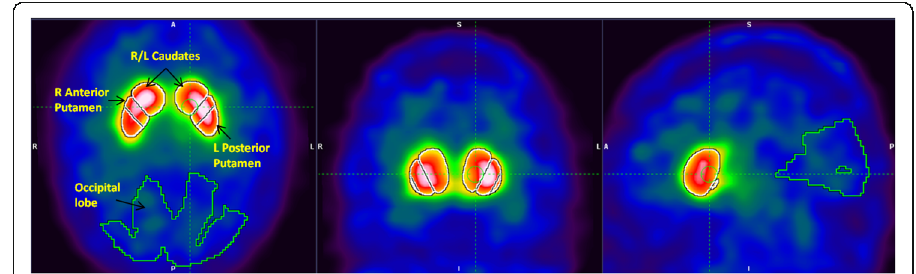
Fig. 2 Axial, coronal, and sagittal views showing predefined striatal and background volumes of interest overlaid on a spatially and intensity normalized 123 I-FP-CIT image. R right, L